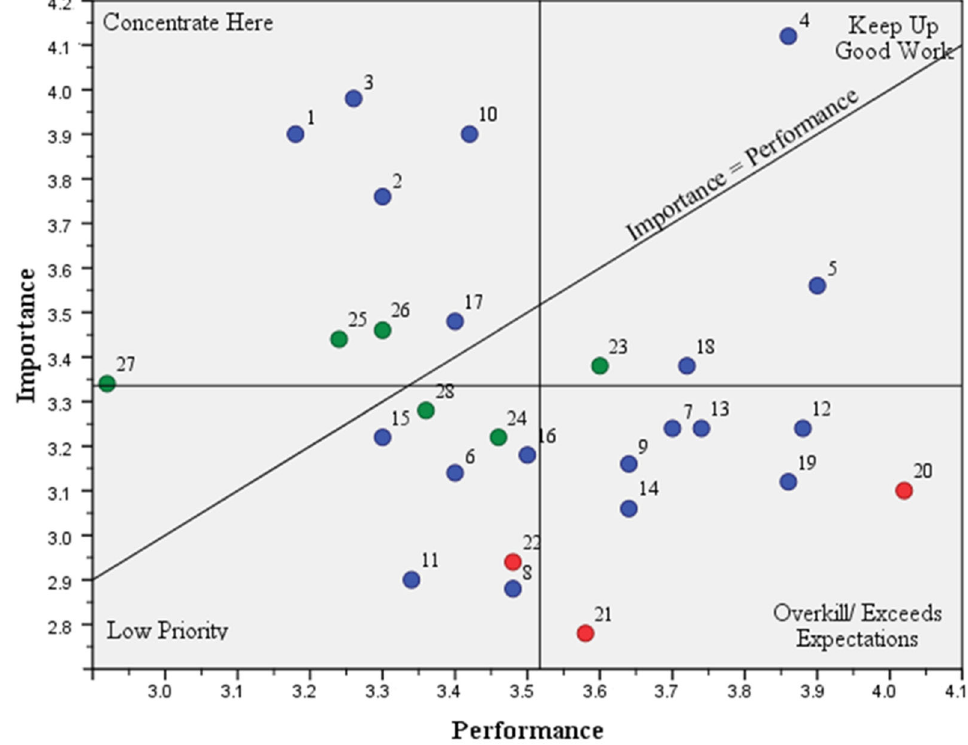
Figure 5. IPA matrix for FSC certification attributes reported in Table 3. (Indicated in blue: business- related attributes, red: social attributes, green: environmental attributes). Cross-hairs are placed at the mean values for the Importance and performance of the attributes. The diagonal line of parity highlights the attributes with no significant gap in performance (i.e., performance = importance).